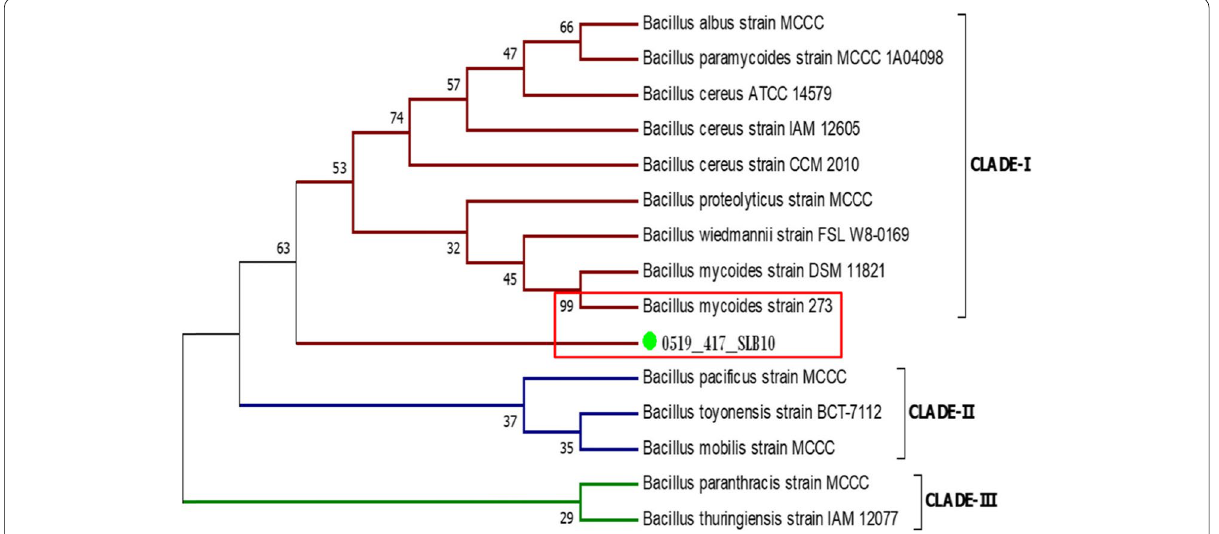
Fig. 5 Phylogenetic tree of the ligninolytic strain SLB10 based on 16S rRNA